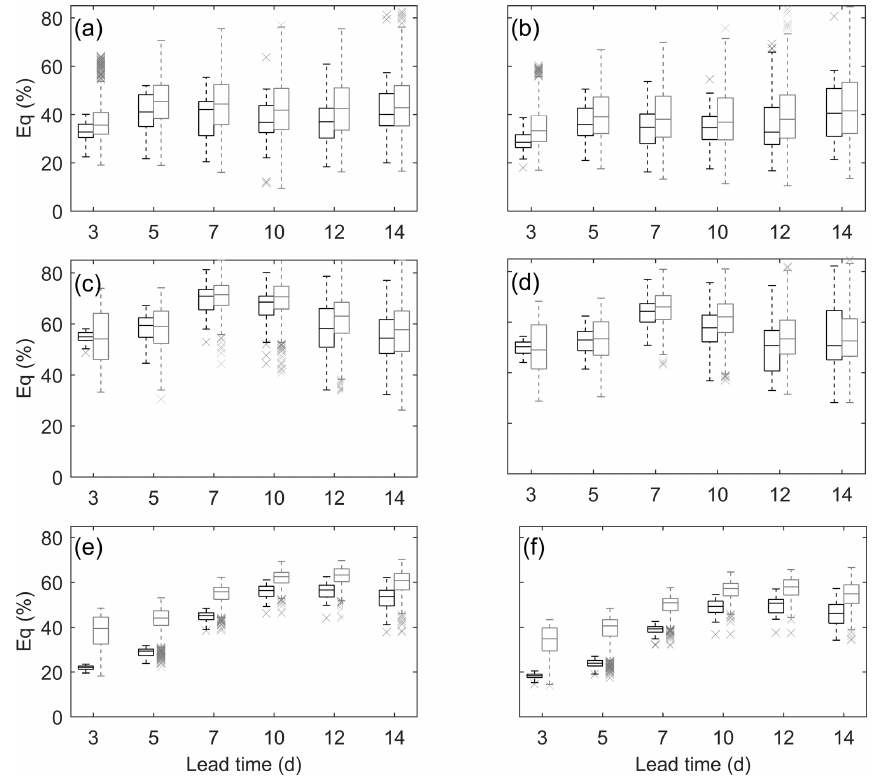
Figure 7. E q of first floods for Q 1 and Q 7 at (a, b) Nugesha, (c, d) Yangcun and (e, f) Nuxia. The black box plots are forecasts driven by S simulation, and forecasts derived from N simulations are denoted by grey.